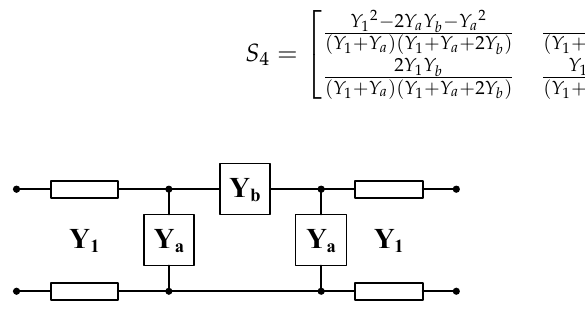
Figure 5. Π-type-equivalent two-port circuit. Figure 5. Π -type-equivalent two-port circuit.